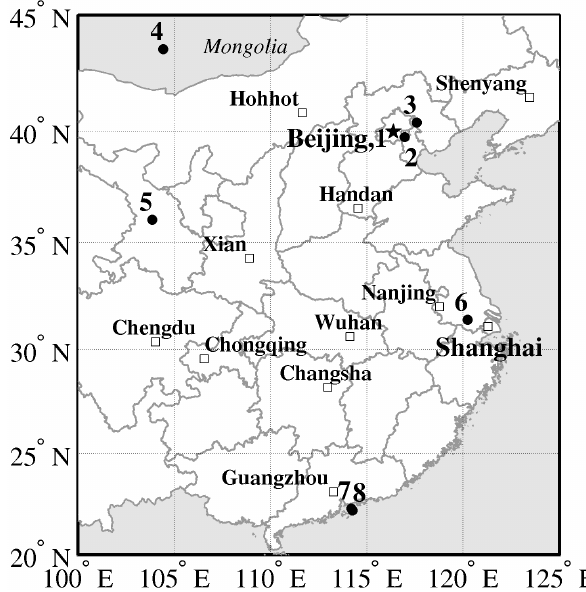
Figure 1. Map of the study area with AERONET stations that pro- vided data during 2009. AERONET stations are 1: Beijing, 2: Xi- anghe, 3: Xinglong, 4: Dalanzadgad, 5: Lanzhou, 6: Taihu, 7: Hong Kong Polytechnic, and 8: Hong Kong Hok